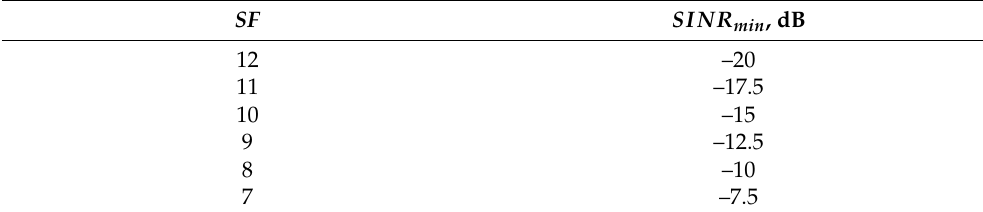
Table 4. Minimal SINR required at the LoRaWAN receiver